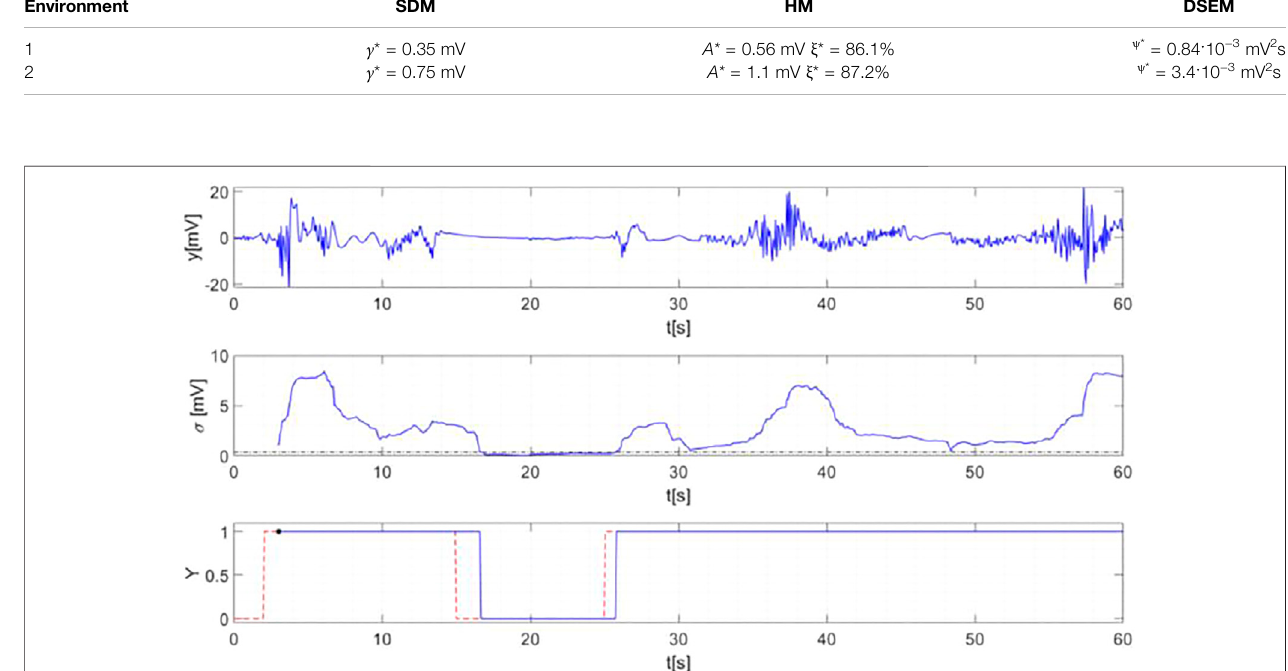
FIGURE12| RadarsignalmeasuredinTest1(toppanel).Standarddeviation(solidline)andoptimalthreshold γ *(dashedline)(middlepanel).SDMoutput(solidline) compared to ground truth (dashed line).